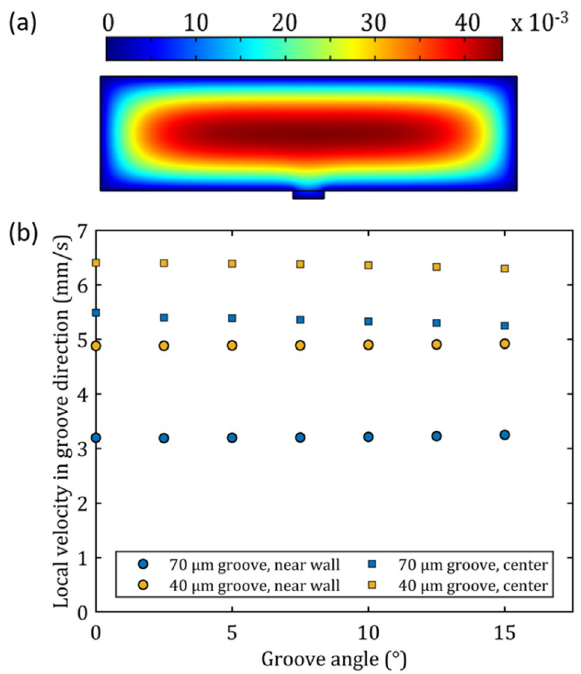
Figure 7. COMSOL simulation at a liquid flow rate of 25 mm s −1 . ( a ) Cross section of the microfluidic channel showing the axial velocity field. ( b ) Local liquid velocity in the direction of the groove for different groove angles and depth, in the center of groove (squares) and close to the groove wall